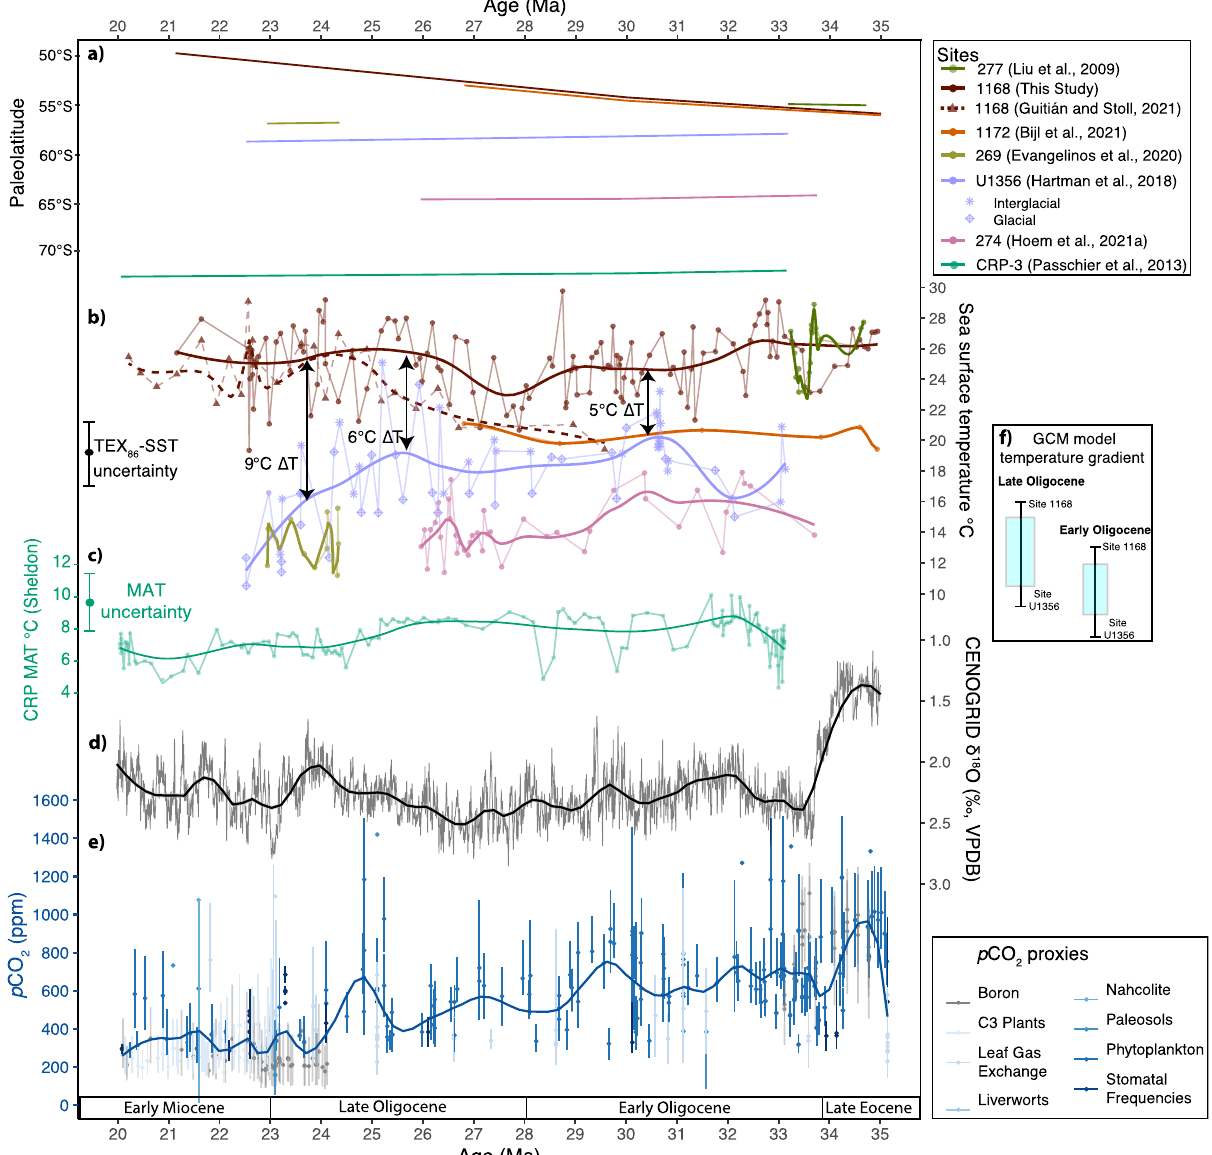
Fig. 2 Late Eocene – Early Miocene Australian-Antarctic Gulf temperature records, with their paleolatitude, compared with global benthic δ 18 O and p CO 65 . Colors refer to sites in Fig. 1. b TEX 86 - SST reconstructions. Thick lines represent 2 records and GCM models. a Paleolatitude evolution of sites smoothed long-term trends, with a local weighted polynomial regression (LOESS; span of 0.35). For the age model of Site 1168 see Supplementary Data 32 . c Mean annual air temperature (MAT) from Site CRP-3 31 . All ages in a – c are converted to GTS2012 51 . d Benthic foraminiferal δ 18 O splice, smoothed by a locally weighted function over 20 kyr (thin black curve; CENOGRID 23 ). Thick black curve is the LOESS smoothed (span = 0.1). e paleo-CO 2 compilation from https://www.paleo-co2.org 10 . The vertical error bars indicate the 95% con fi dence interval for each pCO 2 estimate. Blue curve is the LOESS smoothed (span = 0.1). f Shows the GCM model temperature gradient (corresponding to the scale in b) between Site 1168 and Site U1356 in the Early- and Late